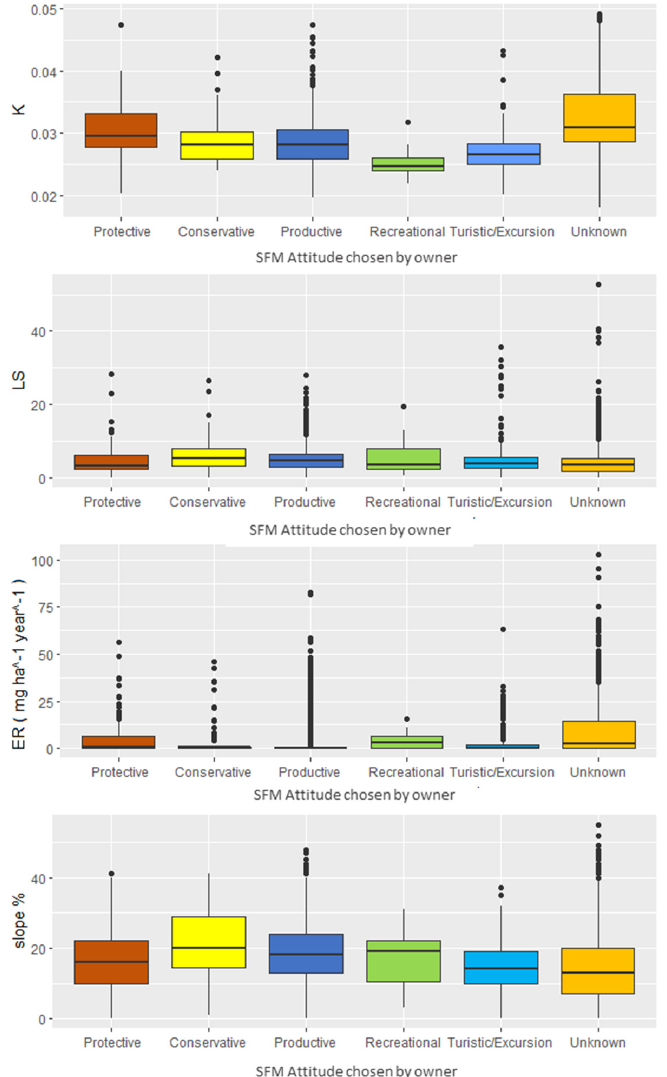
Figure 5. Distribution of values for K, LS, ER, and slope according to primary SFM attitude of parcel in Forest Sharing ® platform.